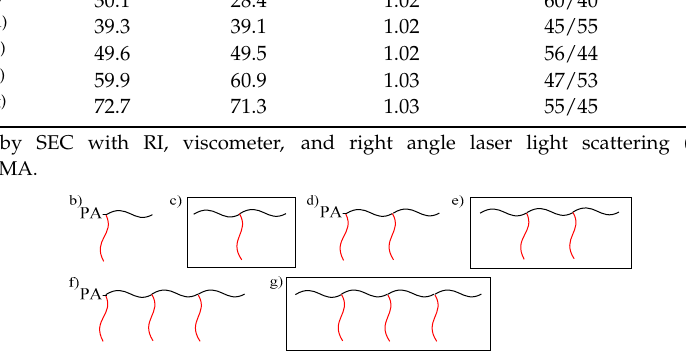
Table 8. Characterization results of (EDGP)s by the iterative